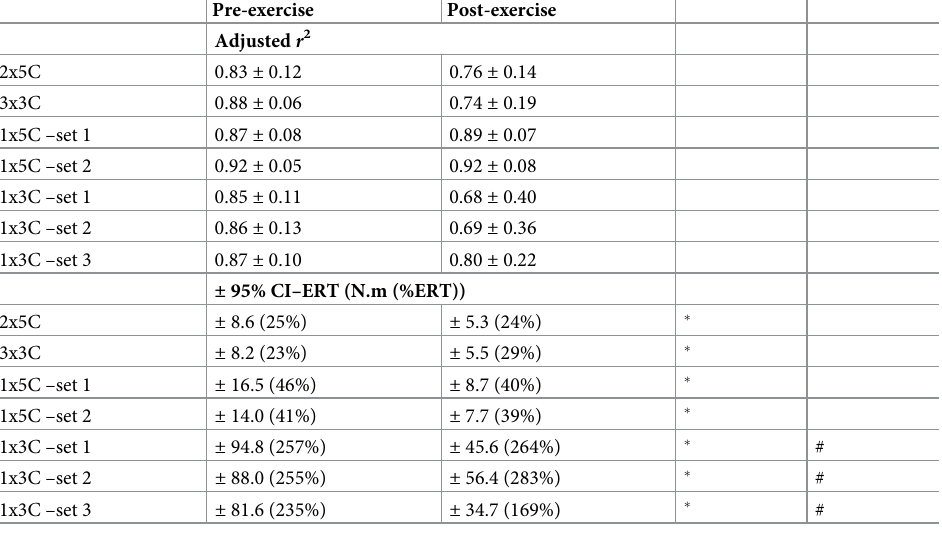
� Significantly different from pre- to post-exercise (P < 0.05)